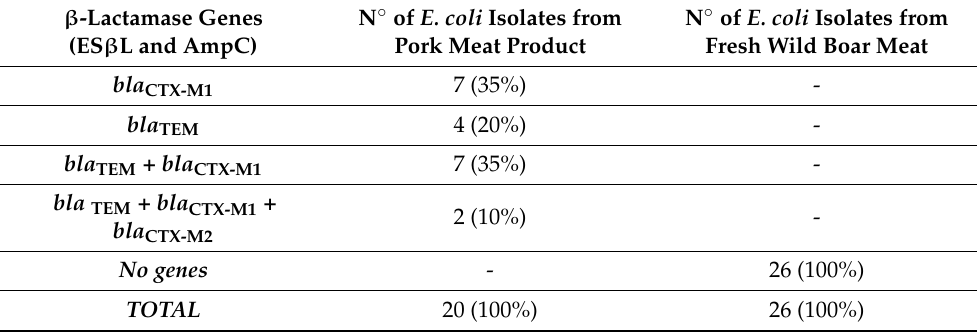
Table 2. Distribution and combination of ES β L and AmpC genes in E. coli isolated from pork and fresh wild boar meat defined as “intermediate” in the screening test with CTX and CAZ. β -Lactamase